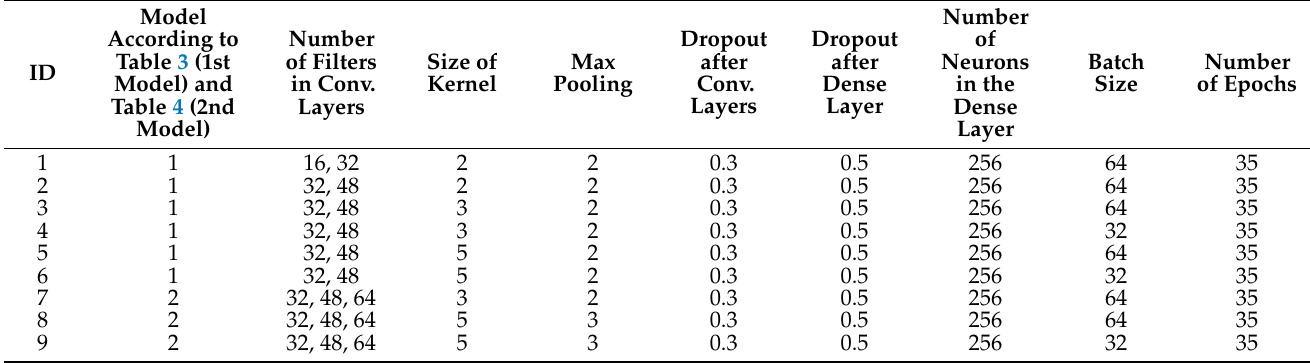
Table 5. Configuration of the learning process for speech type